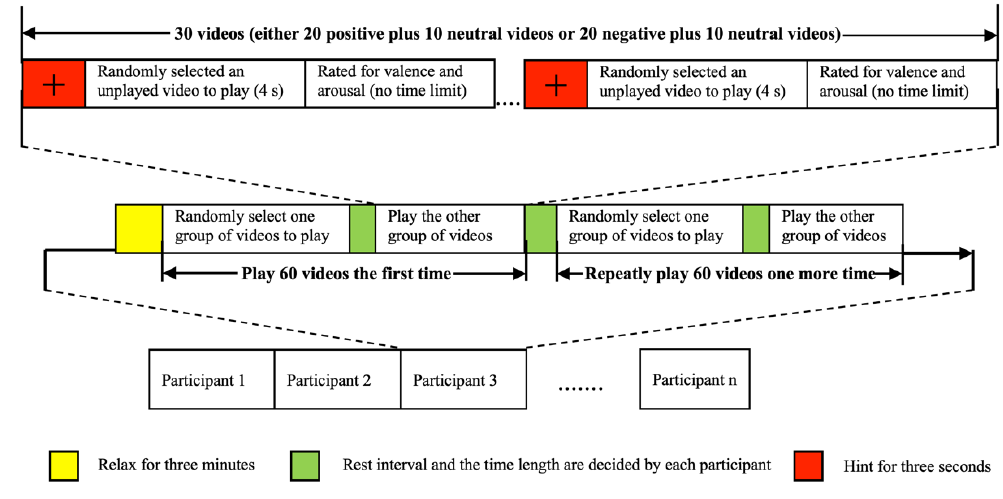
Figure 3. The dataset collection protocol [38].